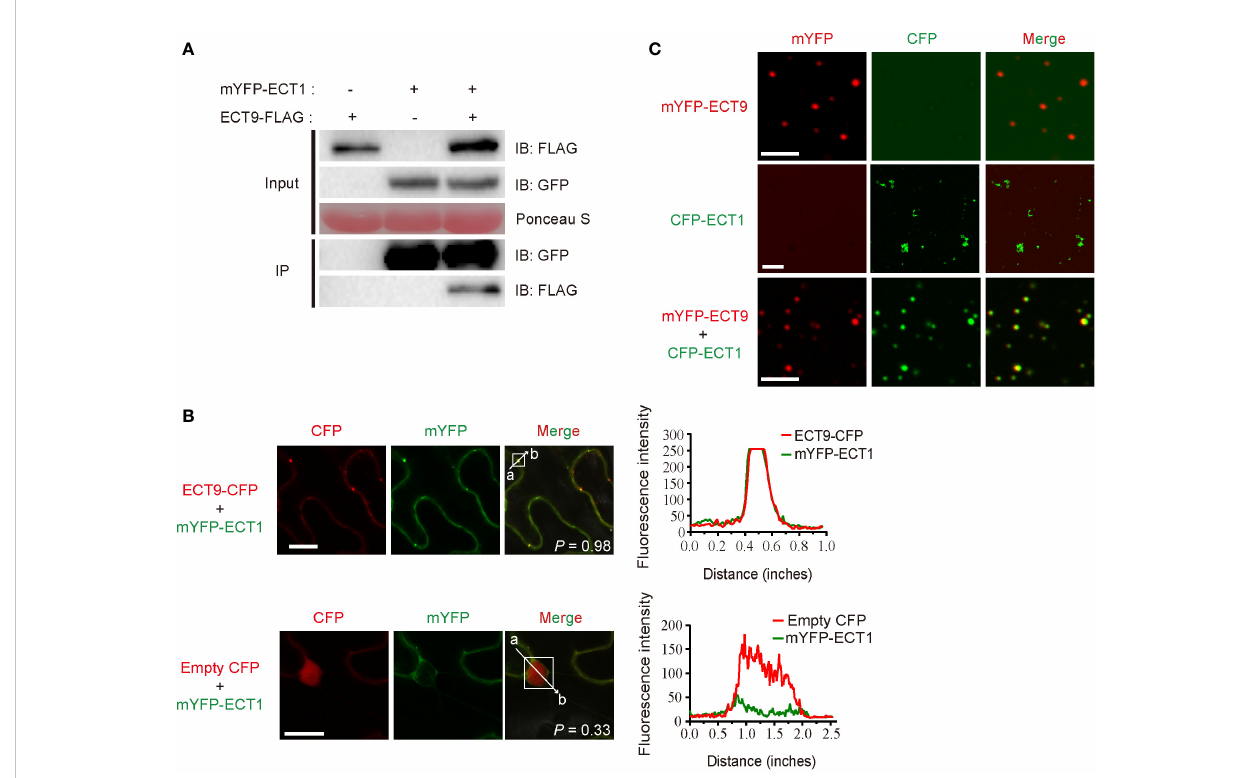
FIGURE 3 ECT9 directly interacts and co-phase separates with ECT1. (A) Co-IP assay showing the interaction between ECT9 and ECT1 expressed in N. benthamiana leaves. Extracted proteins were incubated with GFP-trap agarose beads. The immunoprecipitates were analyzed by immunoblotting (IB) with anti-GFP or anti-FLAG antibodies. (B) Co-localization of ECT9 with ECT1.The mYFP-ECT1 fusion proteins were co-expressed with ECT9-CFP or empty CFP fusions in N. benthamiana leaves. Scale bar, 20 µm. The right panels show plots of relative CFP (red) or mYFP (green) fl uorescence intensity along the line from a to b depicted in the corresponding merged images. Solid white line rectangles indicate the area used to calculate the co-localization score ( P , Pearson ’ s R -value) depicted at the bottom-left of merged images. (C) Co-condensation of ECT9 with ECT1. The puri fi ed proteins were isolated or mixed for in vitro phase separation (induced condition: 32 µM mYFP-ECT9 and/or CFP-ECT1, 20% PEG8000). Scale bar, 8 µm (top and bottom) and 25 µm (middle). Data are representative of three independent